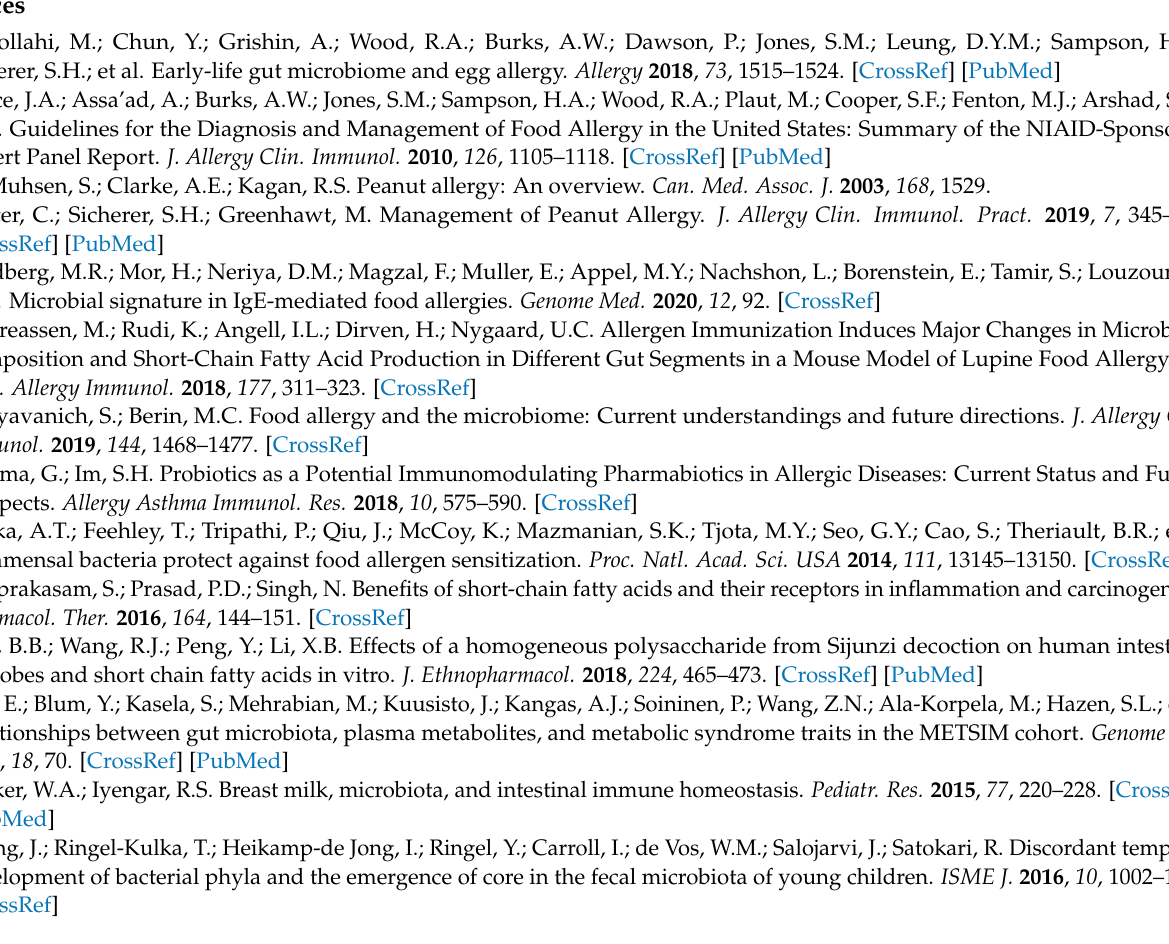
Figure S2. Predicted functions of gut microbiota were analyzed by the Tax4Fun analysis ( n = 6 for PE group; n = 5 for Ad and Ctrl groups). (A) Relative abundance of genes in purine metabolism pathway on level 3. (B) Spearman correlation between sIgE and relative abundance of genes in purine metabolism pathway. R, the Spearman correlation coefficient. P, the significance of